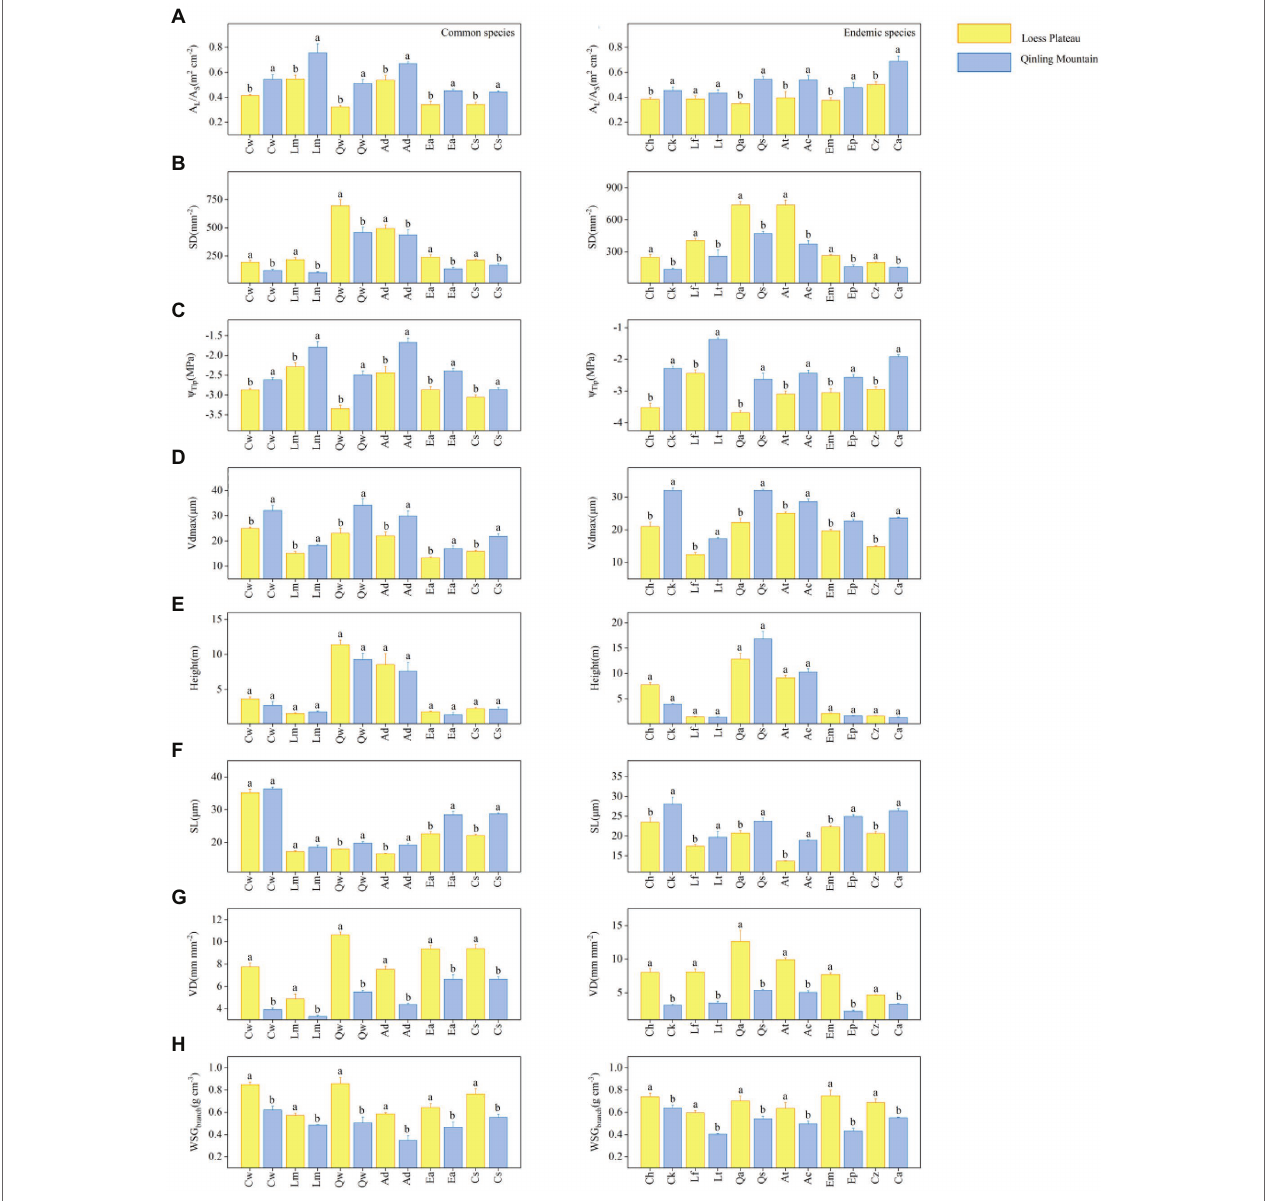
FIGURE 2 | Eight hydraulic traits: (A) leaf area: sapwood area (A l : A s ), (B) Stomatal density (SD), (C) Turgor loss point ( Ψ Tlp ), (D) Maximum vessel diameter (Vd max ), (E) Height (height), (F) Stomatal length (SL), (G) Vein density (VD), and (H) Wood specific gravity (WSG branch ) for 18 special congeneric pairs of species (common species and endemic species in six genera) in Loess plateau (LP; low soil water availability) and Qinling Mountain (high soil water availability). The species abbreviations are shown in Figure 1 . Error bars represent 1 SE, and different letters indicate significant differences between regions ( p <